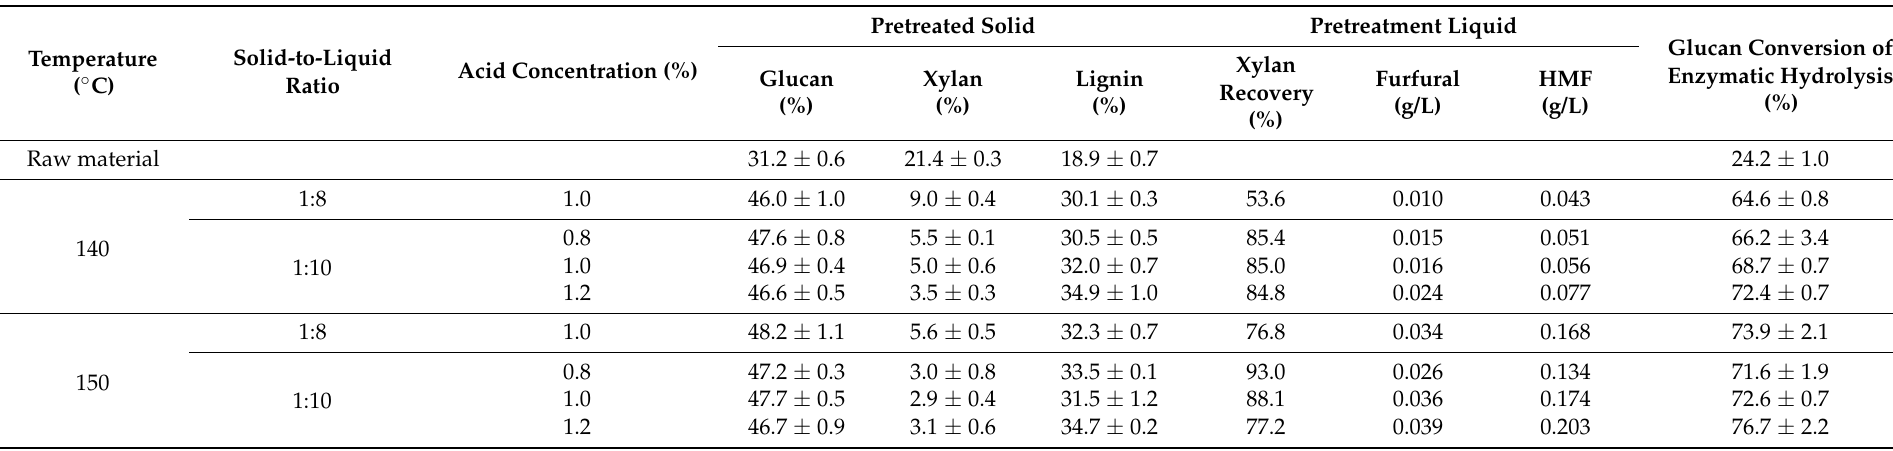
Table 1. Effects of dilute acid pretreatment on chemical compositions of corn stover, xylan recovery, inhibitors formation, and glucan conversions at 72 enzymatic